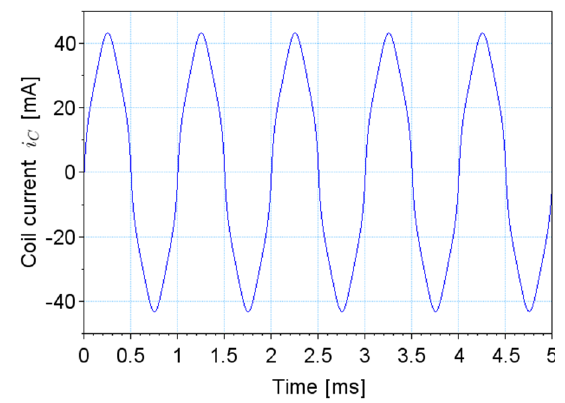
Figure 6. Inductor current i c waveform.